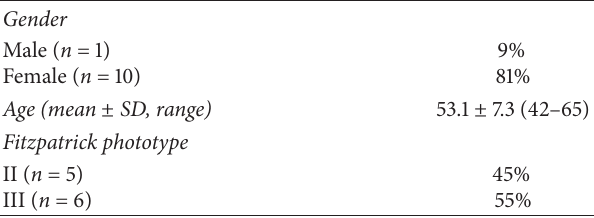
Table 1: Demographic characteristics of the treated